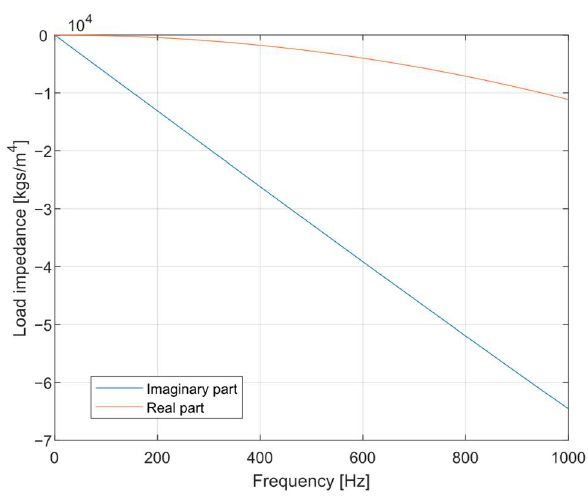
Figure 7. Real and imaginary parts of outlet impedance of a 45.2 mm diameter tube.